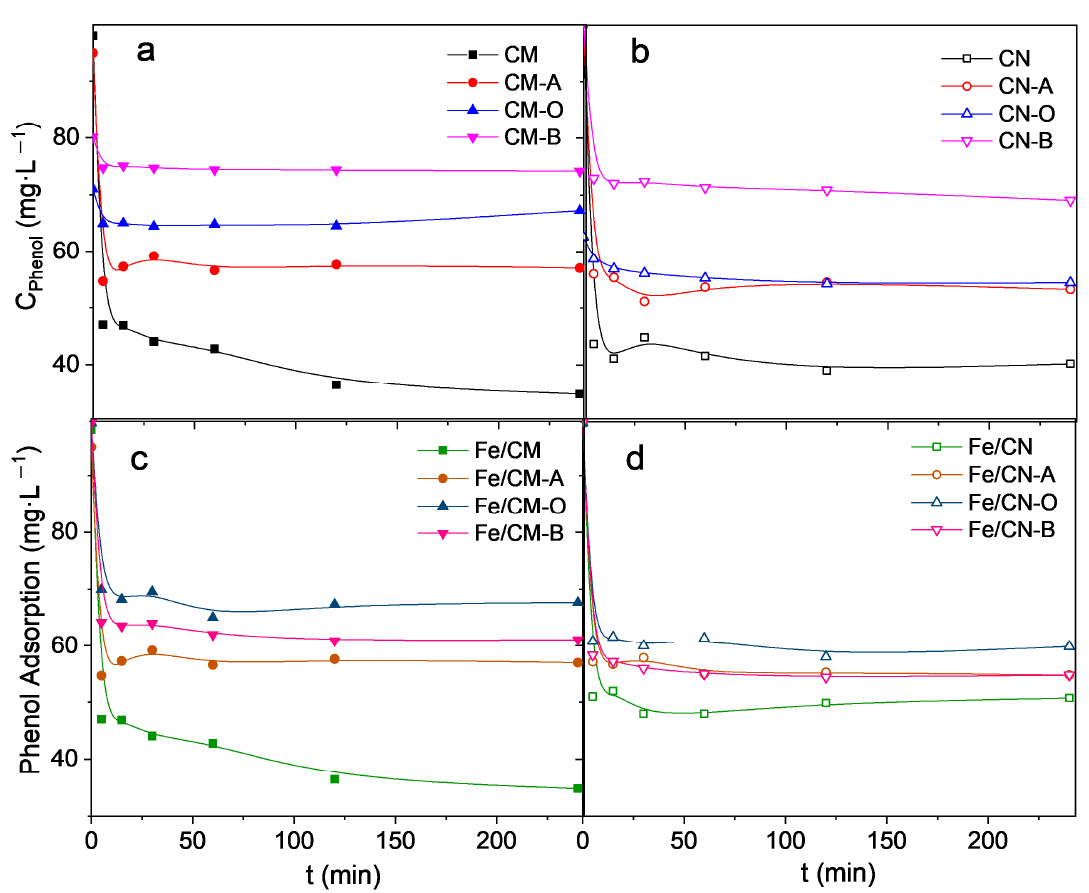
Figure 2. Evolution of phenol CWPO reaction on AC and AC- f supports: ( a ) CM- f and ( b ) CN- f . And evolution of phenol adsorption on Fe/AC- f catalysts: ( c ) Fe/CM- f catalysts and ( d ) Fe/CN- f catalysts. Reaction conditions: 50 mL reaction vol-